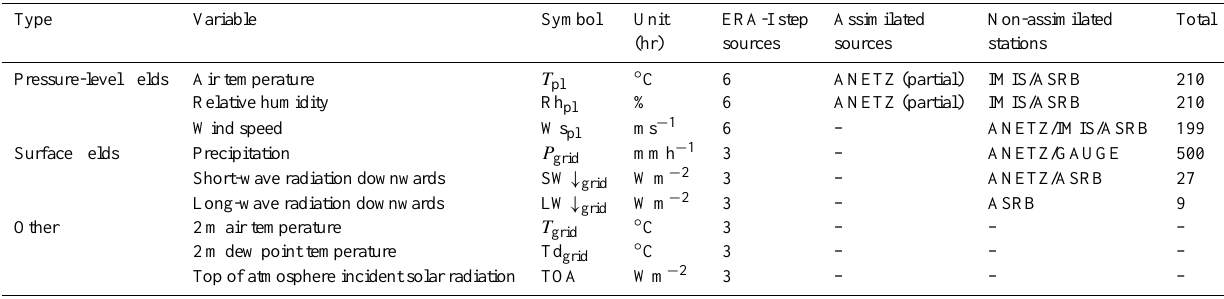
Table 1. Pressure-level and surface fields indicate variables which are computed, time steps they are obtained on from ERA-I, sources of validation data (assimilated or non-assimilated), and total stations used in evaluation. Variables in section “other” are used only to support calculations, and therefore columns related to validation are blank.